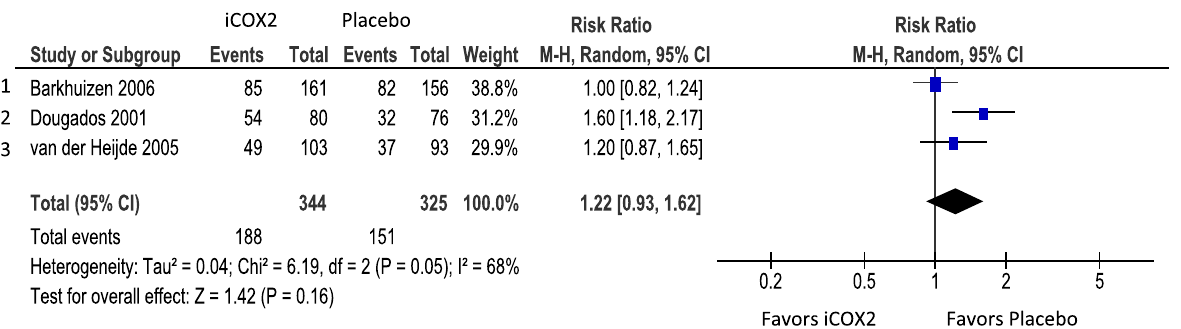
Fig. 6 Incidence of any adverse events in the comparison of selective COX-2 inhibitors versus placebo in patients with ankylosing spondylitis: meta- analysis of three randomized clinical trials. Subtitle: (1) Celecoxib 400mg vs placebo. (2) Celecoxib 200mg vs placebo. (3) Etoricoxib 90mg vs